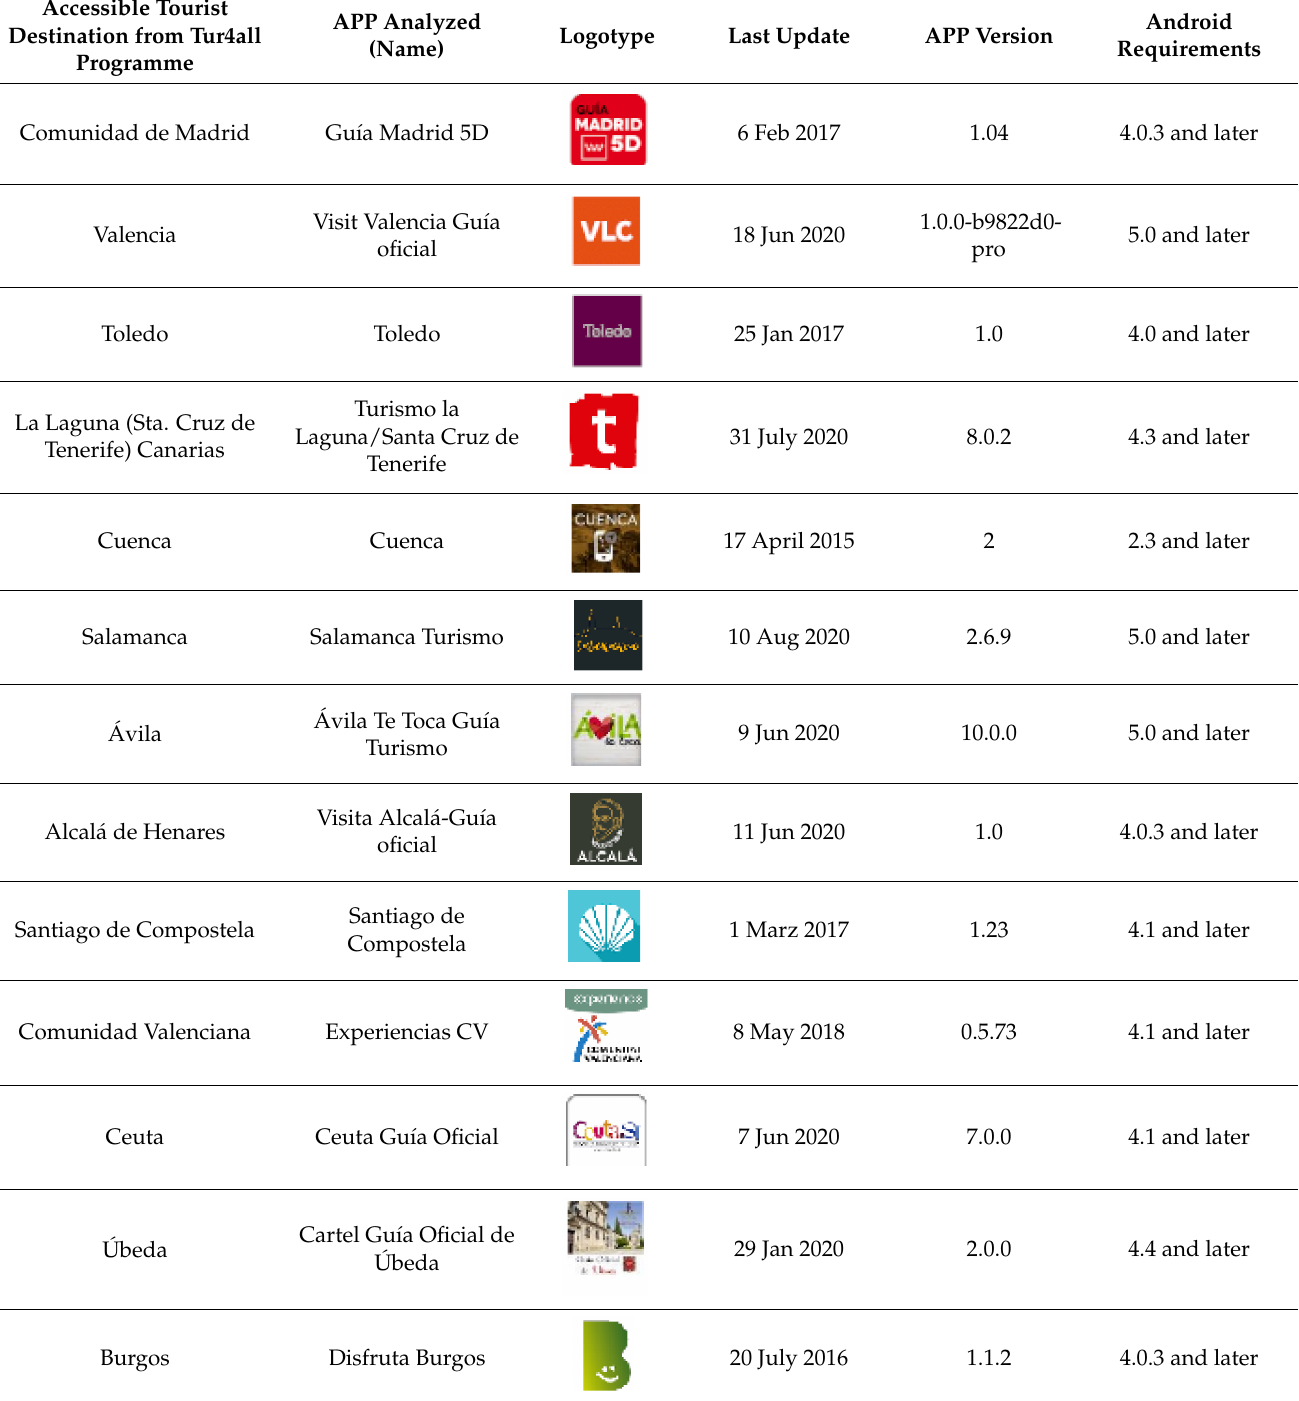
Table A3. Spanish accessible destinations from the Tur4all.es platform analyzed as a sample from the accessibility point of view of their mobile tourism